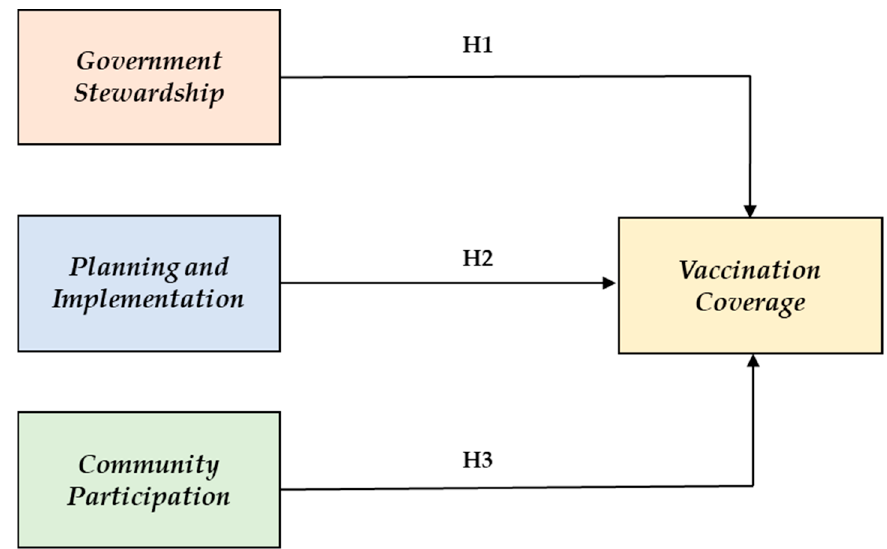
Figure 1. Model for empirical testing.